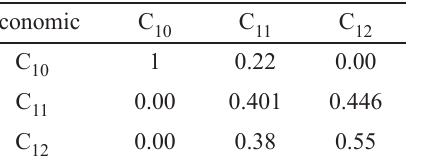
Table 8. The weight matrix of inner dependence for criteria the under Economic Group